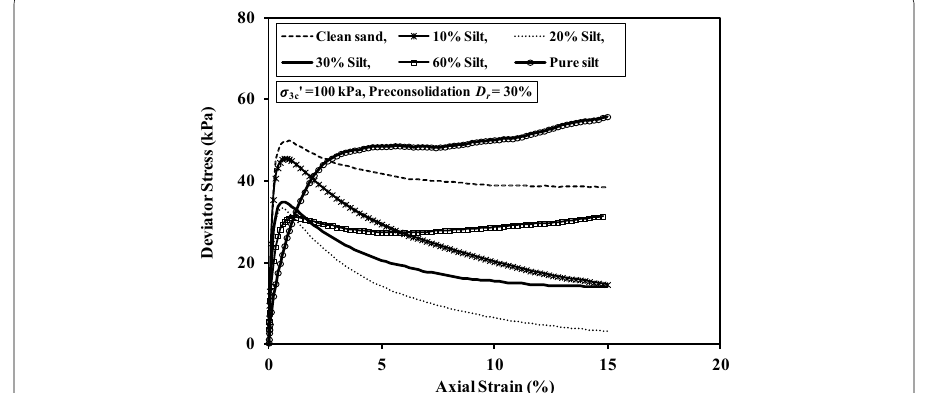
Fig. 8 Stress–strain relationship at 30% relative density